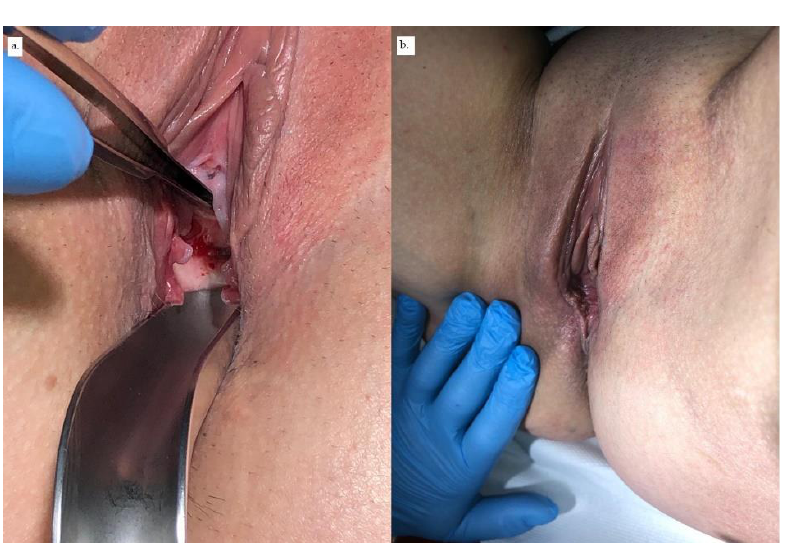
Figure 3. ( a ) Wound healing of the area of fistula vaginal opening. ( b ) Healed area of the right labia